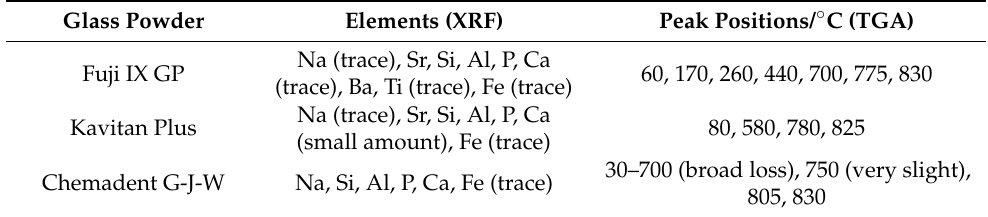
Table 1. Peak positions in differential thermogravimetric traces and elemental composition of glass powders from